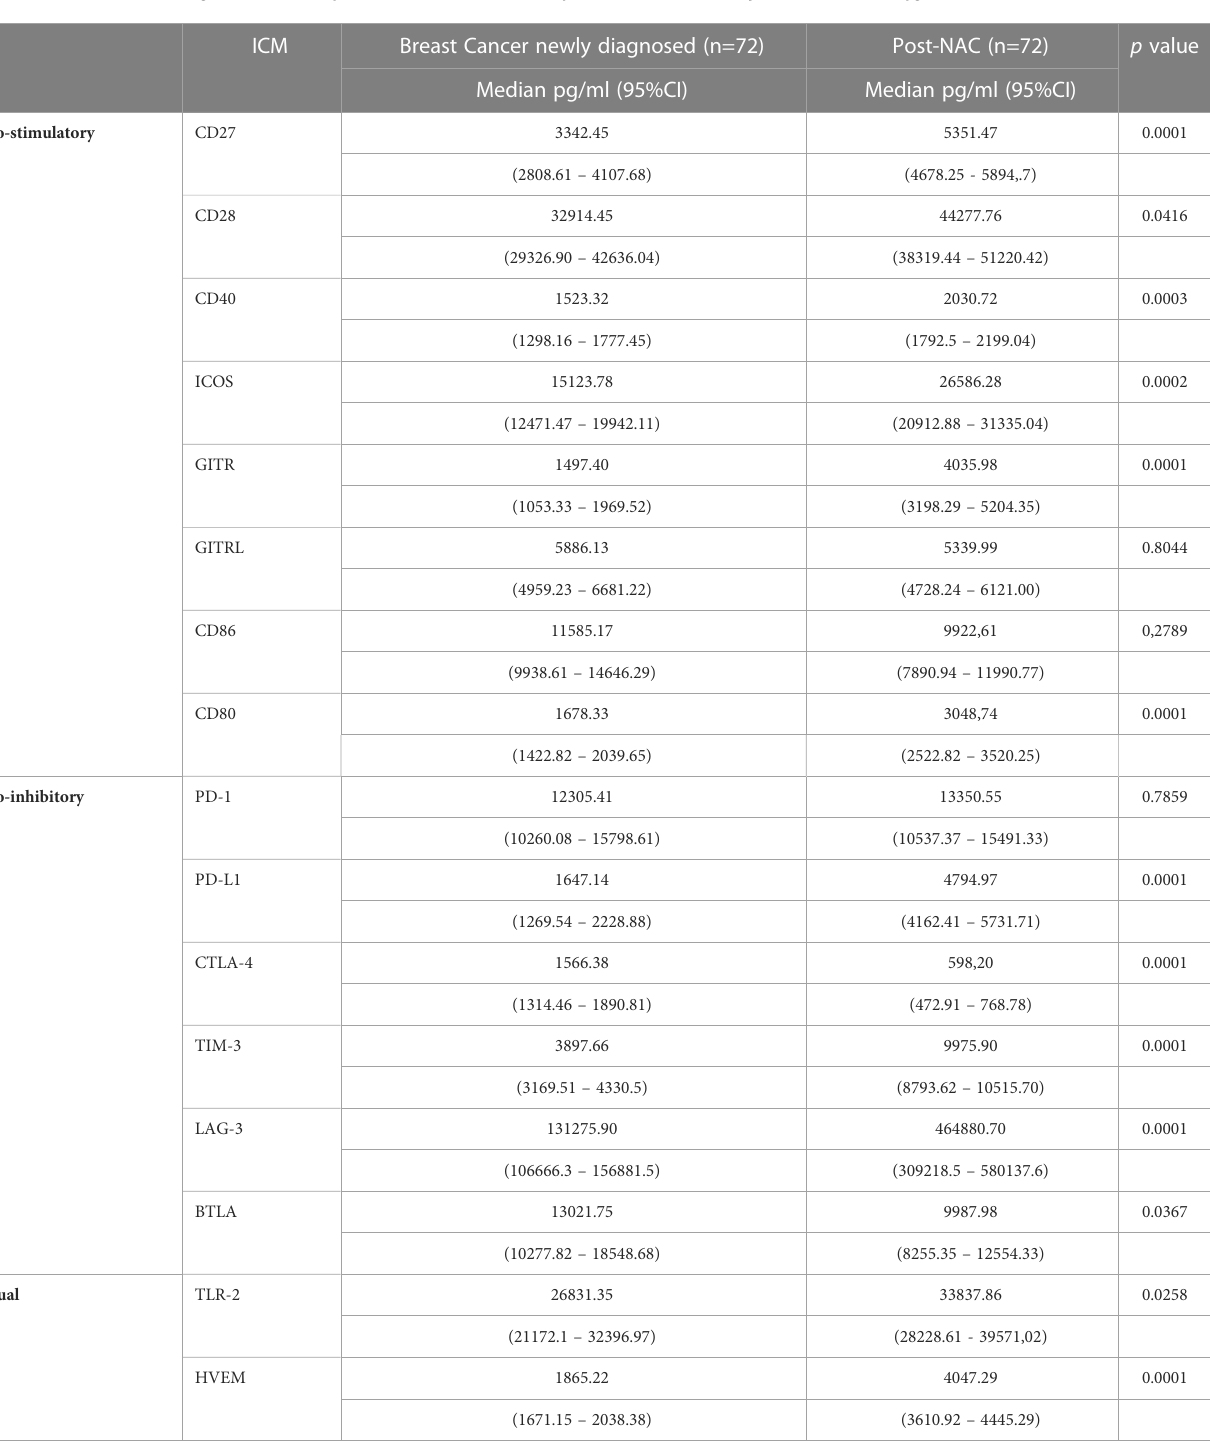
TABLE 3 Comparison of the concentrations of the soluble co-stimulatory, co-inhibitory and dual-activity immune checkpoints measured in the plasma of the cohort of early breast cancer patients before and after implementation of neoadjuvant chemotherapy